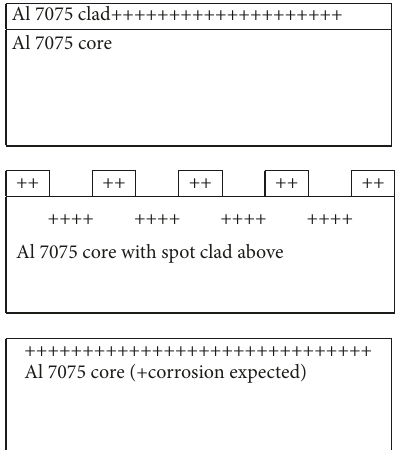
Figure 1: Schematic cross sections of the three medium sized test panels indicating the location (+) of corrosion products expected after corrosion testing. All test panels have visual exposed areas of 30 × 25 cm to salt spray. Alclad means full clad, while spot clad (partial clad) and unclad were machined to remove part or all of the clad layer.